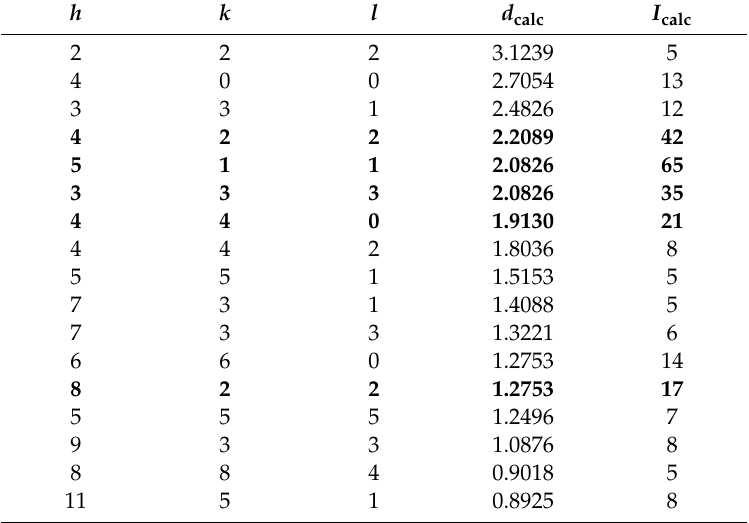
Table 5. Calculated X-ray powder di ff raction pattern for tsikourasite (Cu K α ). The strongest reflections are given in bold.